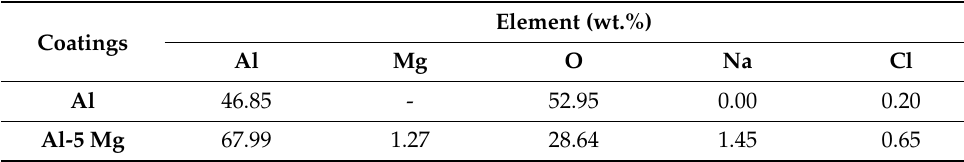
Table 4. EDS analysis of the corrosion